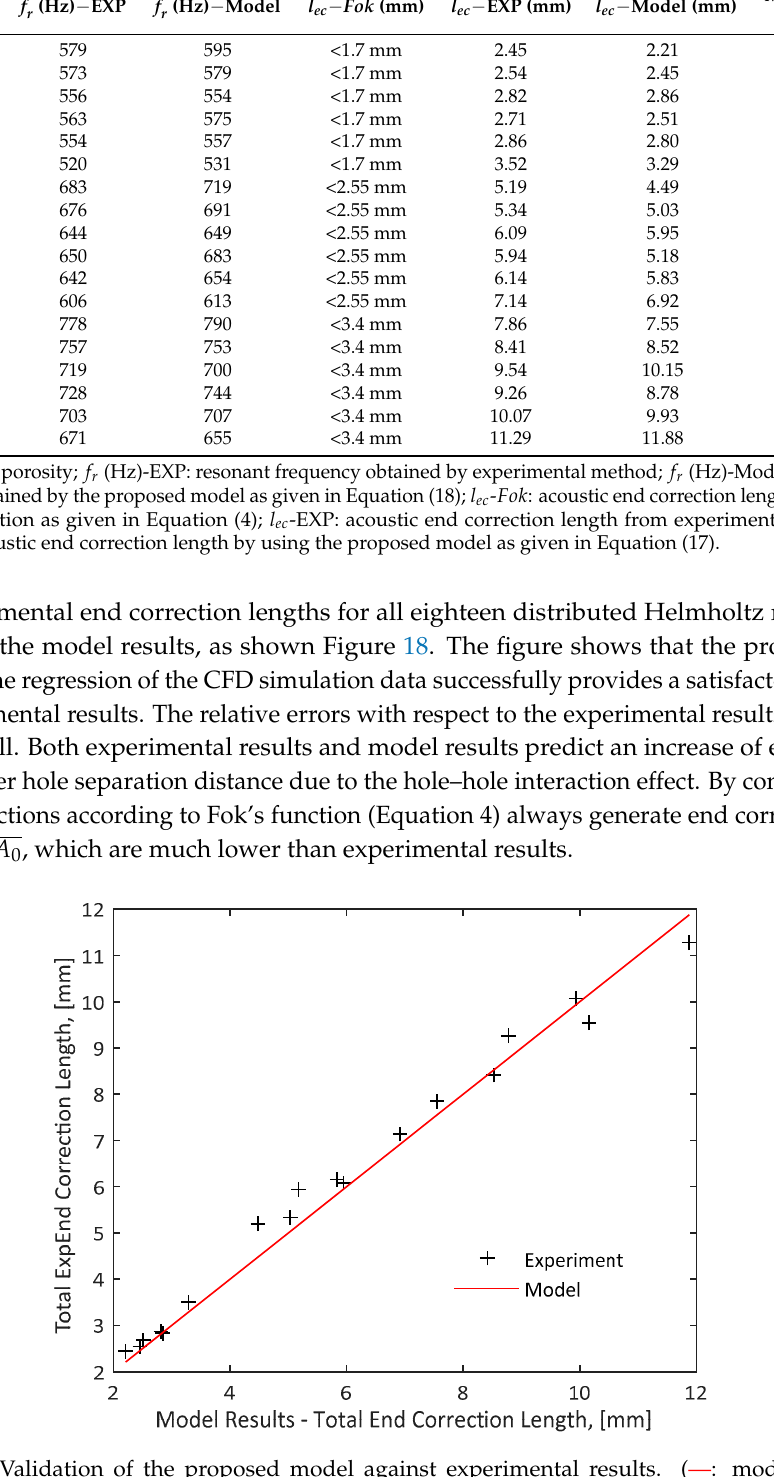
Figure 18. Validation of the proposed model against experimental results. (—: model results, ＋: experiment results).